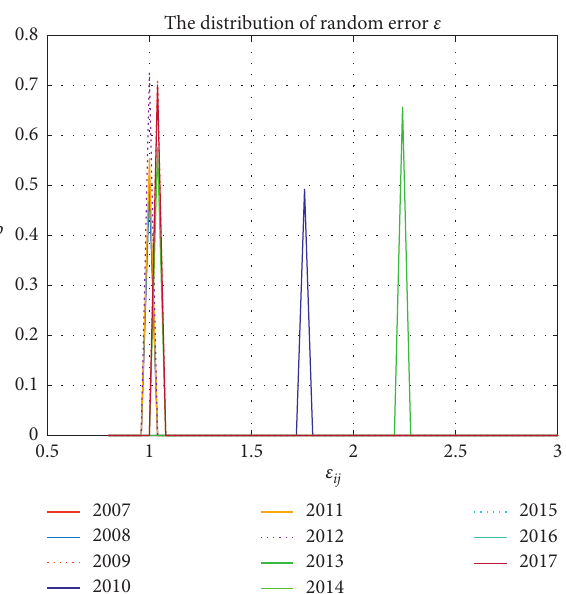
Figure 8: The random error obeys lognormal distribution during